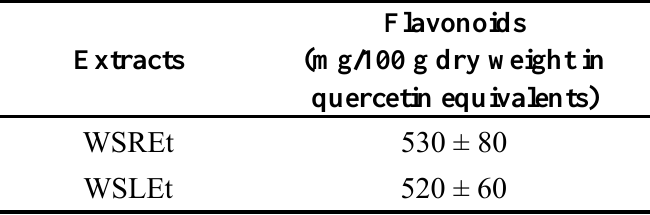
Table 1. Total content of flavonoids of Withania somnifera root and leaf